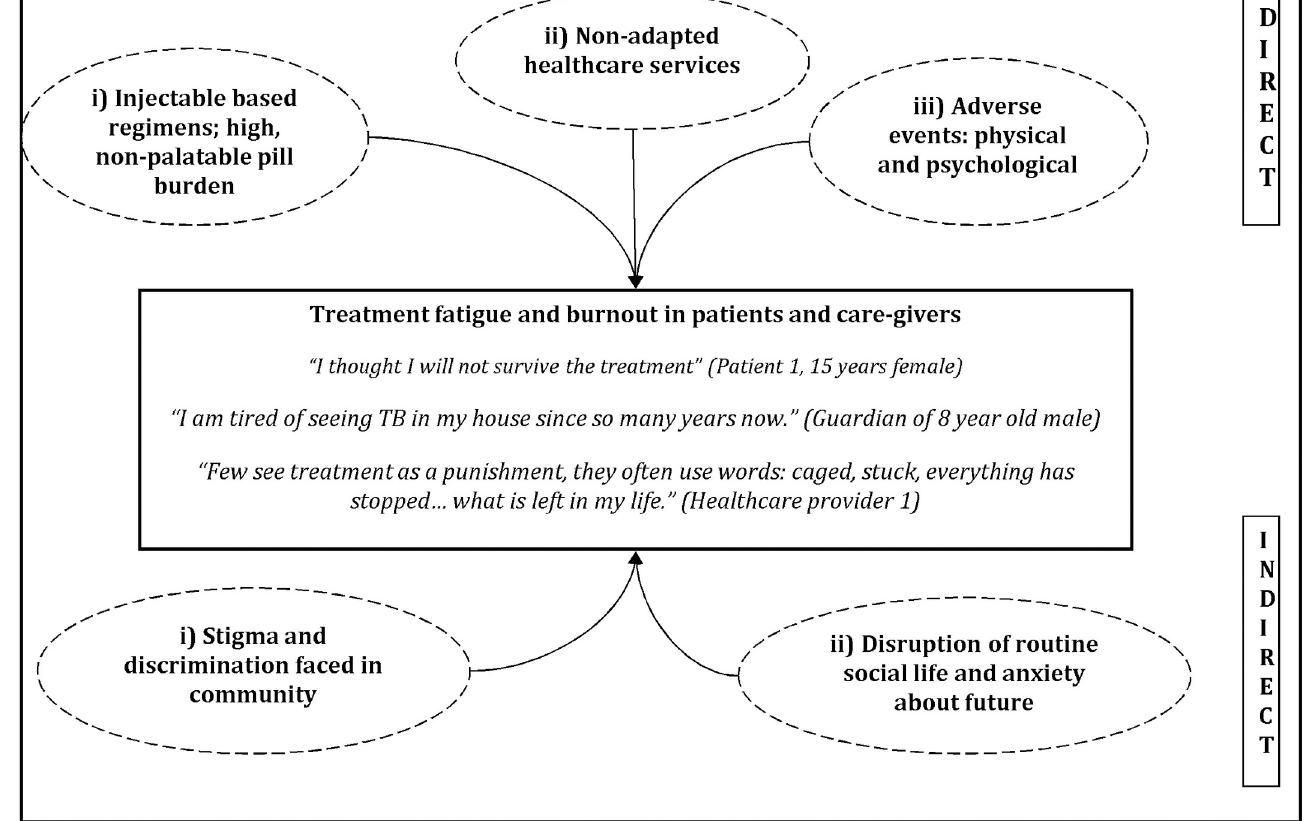
Fig 2. Factors of treatment fatigue and burnout in children and adolescents with DR-TB and their caregivers, Mumbai, India, 2019.